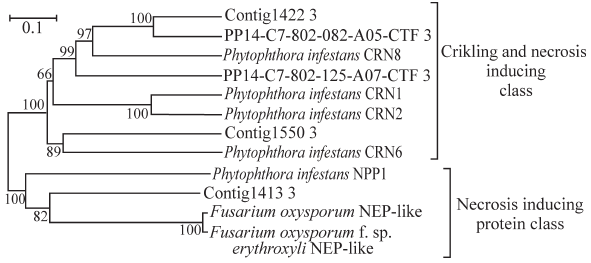
Figure 5 - Analysis of amino acid sequences of necrosis-inducing pro- teins. Dendrogram built by alignment of the selected amino acid se- quences of the necrosis-inducing proteins. The tree was constructed and visualized by Mega using the Neighbor-joining method. The following se- quences were obtained from EMBL GeneBank: the crinkling and necrosis inducing class clade showed Phytophthora infestans CRN1 gi|23394425, CRN2 gi|23394429, CRN6 gi|66270141 and CRN8 gi|66270145 with the clusters Contig1433, Contig 1550, PP14-C7-802-082-A05-CT.F and PP14-C7-802-125-A07-CT.F. In necrosis inducing protein clade showed the cluster contig1413 with the P. infestans NPP1 gi|66270095, F. oxyxporum NEP-like gi|86371279 and Fusarium oxysporum f. sp. erythroxyli gi|2697132. The scale is corrected for multiple substitutions. The numbers indicate percentages supporting the branches by 10,000 bootstrap replicates (bar corresponds to 0.1 substitutions per